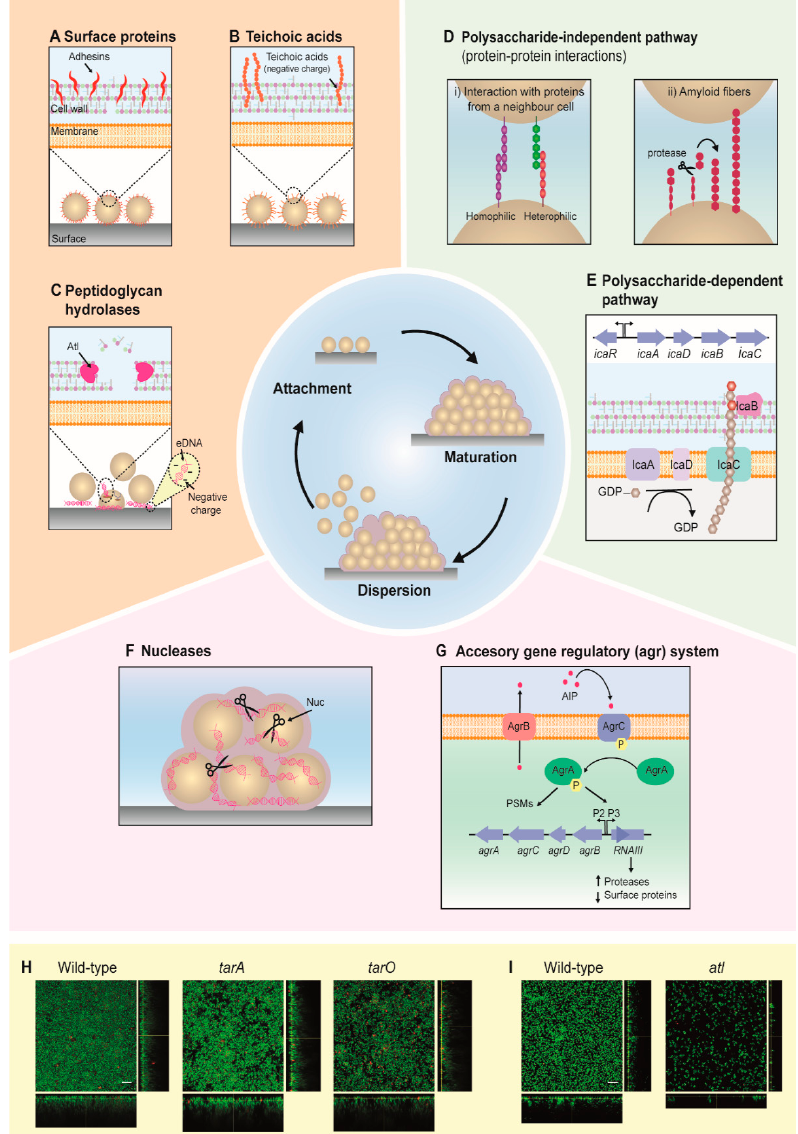
Figure 1. Stages and pathways involved in staphylococcal biofilm development.( A – C ) During the attachment stage, an initial population of staphylococcal cells adhere onto a surface via ( A ) surface proteins, ( B ) teichoic acids and/or ( C ) eDNA released from cells, the latter due to cell lysis medi- ated by peptidoglycan hydrolases like AtlA/E and Sle1.( D – E ) The maturation stage is mediated by